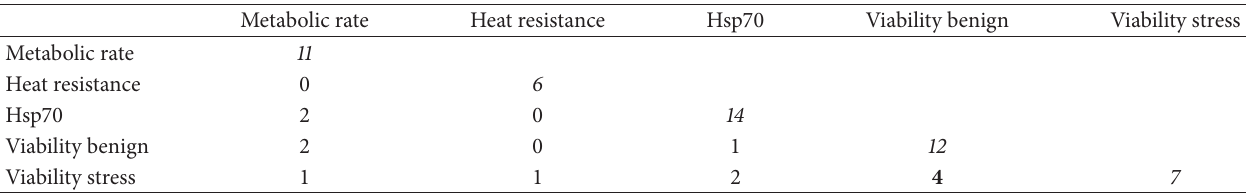
Table 4: Cellular component (a total of 161 GOs). Diagonal elements (italicized numbers) are the number of GOs with a 𝑝 < 0.05 . The off- diagonal elements show the number of elements shared between traits. Numbers in bold indicate a significant overlap. At a 𝑝 value of 0.05 one can expect eight false-positive SNP-sets to be assigned as significant and one SNP-set assigned as